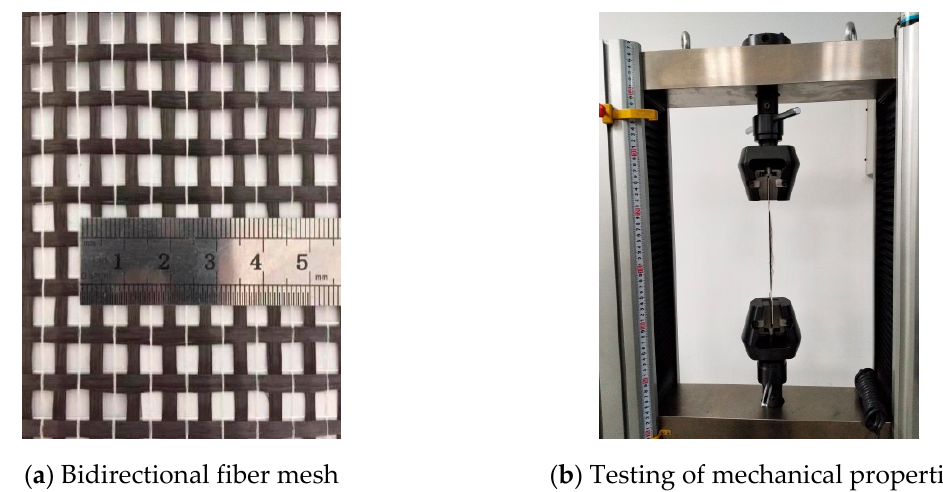
Figure 5. Bidirectional fiber mesh and mechanical properties test of carbon fiber bundles.